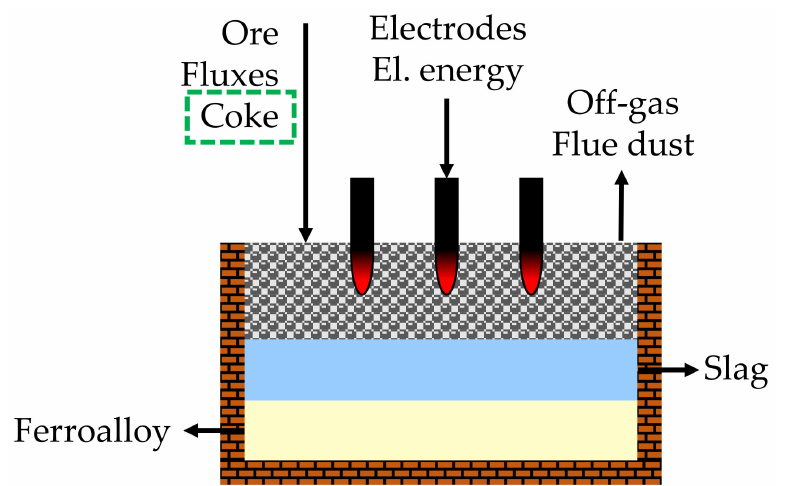
Figure 8. Schematic submerged arc